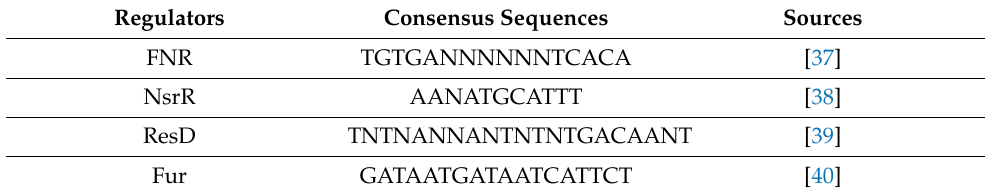
Table 1. Consensus sequences of DNA binding